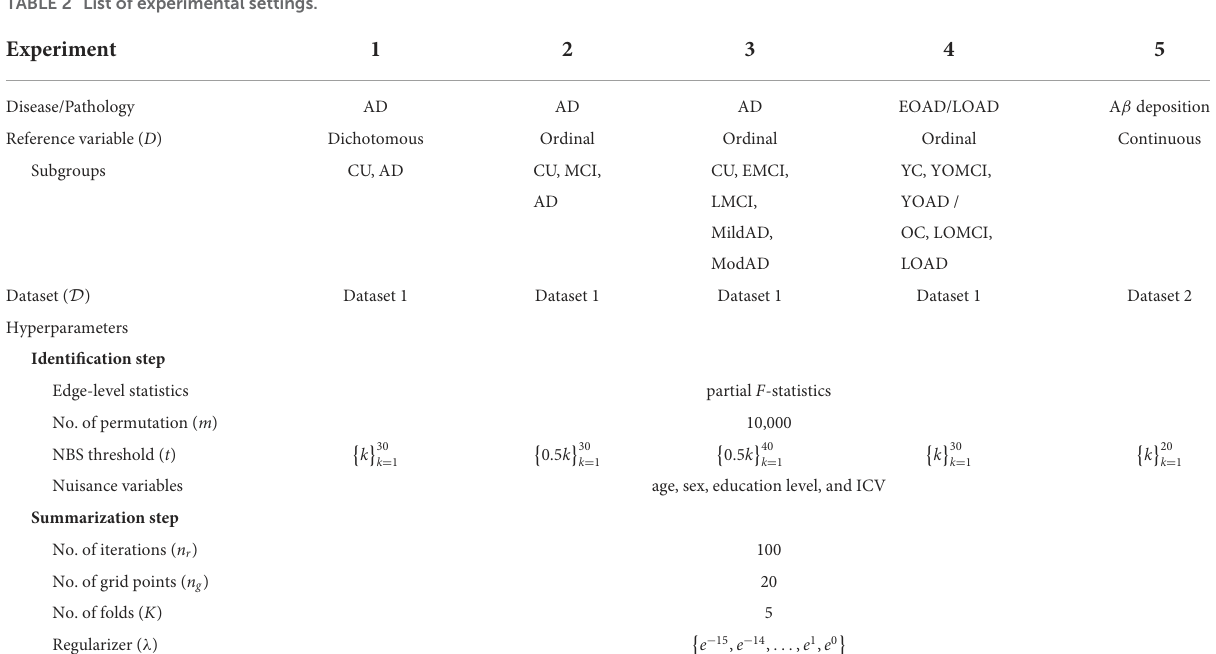
TABLE 2 List of experimental settings.